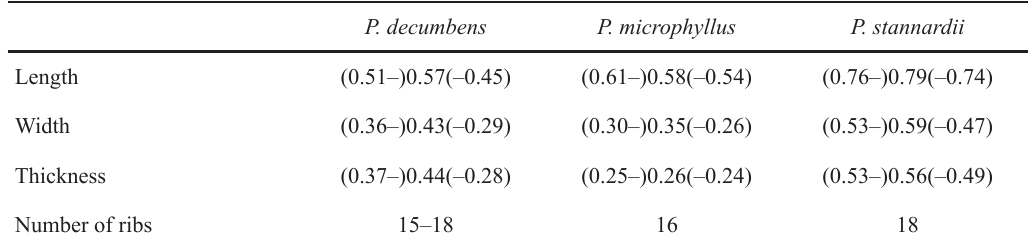
Table 2 – Main morphometrical parameters of seed morphology of Paepalanthus decumbens , P. microphyllus , and P. stannardii . Measurements from 30 seeds from 2 specimens per species are all in mm, expressed as